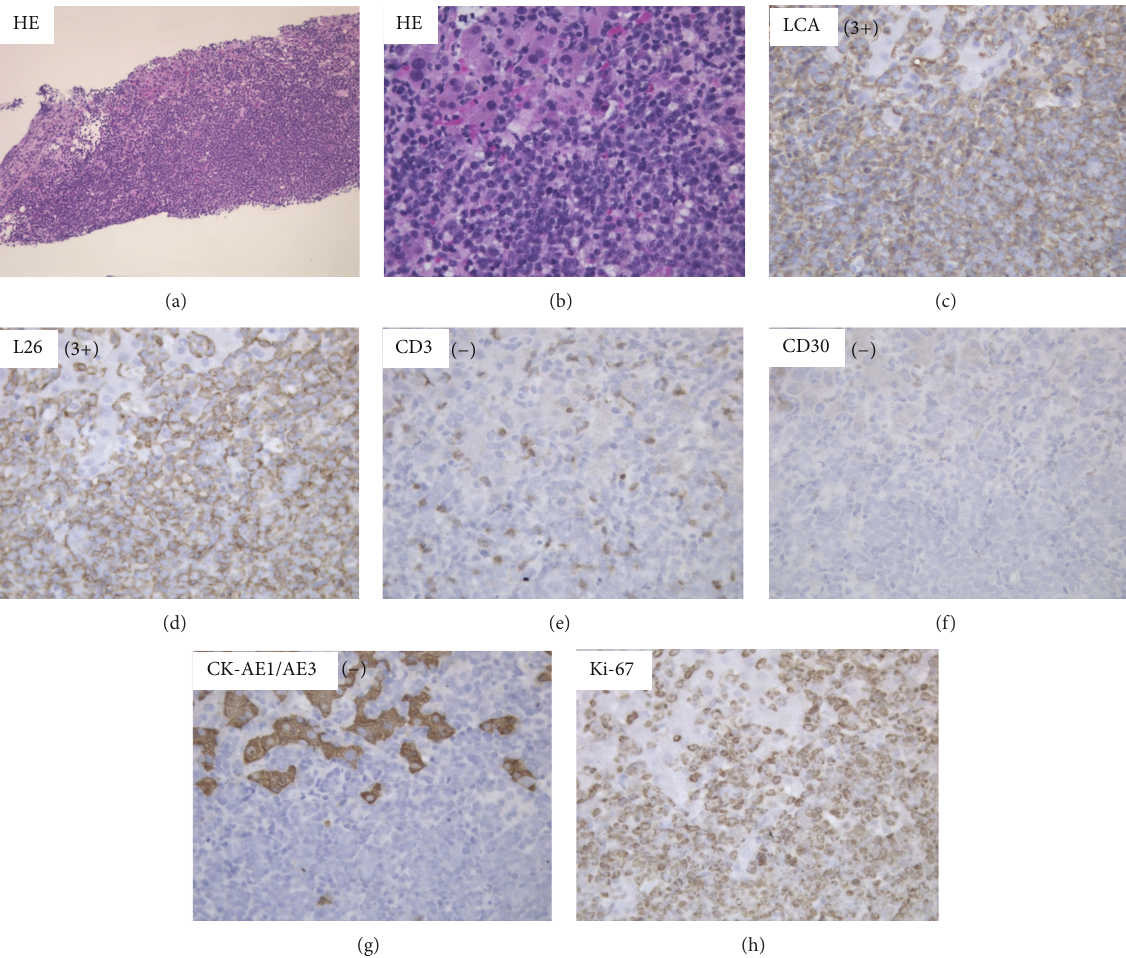
Figure 5: Histopathological findings. Histopathological findings from the biopsy specimens revealed the following. Diffuse and atypical large cells were revealed by hematoxylin and eosin staining ((a) and (b)). Immunohistochemical staining was positive for anti-LCA (CD45) and anti-L26 antibodies and negative for anti-CD3, anti-CD30, and anti-cytokeratin AE1/AE3 antibodies; Ki-67 staining was positive in 53% of cells